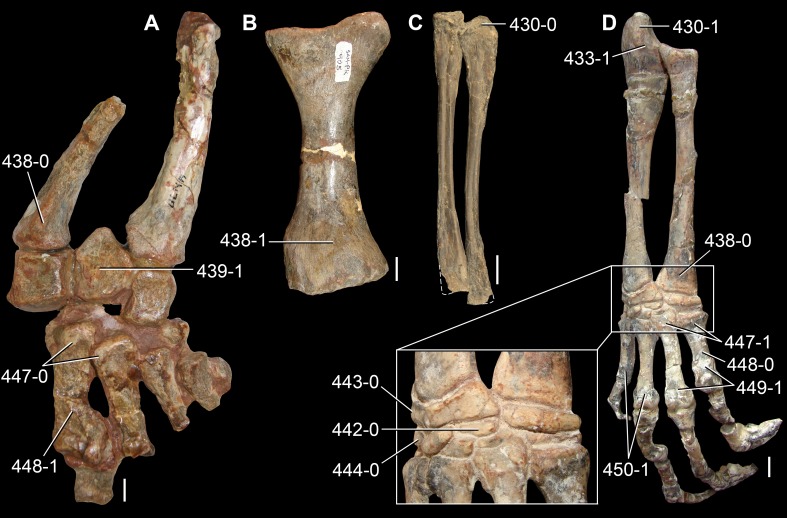
Anterior zeugopodia and autopodia of Triassic and Early Jurassic archosauromorphs in (A, D) anterior/dorsal and (B, C) posterior/ventral views.(A) Left distal halves of the ulna and radius, carpal region and partial manus of Riojasuchus tenuisceps (PVL 3827); (B) right radius of Erythrosuchus africanus (SAM-PK-905); (C) right ulna and radius of Macrocnemus bassanii (PIMUZ T4355); and (D) right lower forelimb of Heterodontosaurus tucki (SAM-PK-K1332). Close up of the carpals in anterior/dorsal view in (D). Numbers indicate character-states scored in the data matrix. Scale bars equal 5 mm in (A, C, D) and 2 cm in (B).